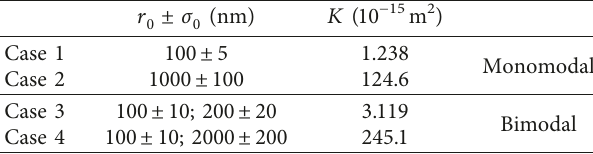
and maximum radius filled r fw fill Table 1: Pore-size distributions and absolute permeabilities.